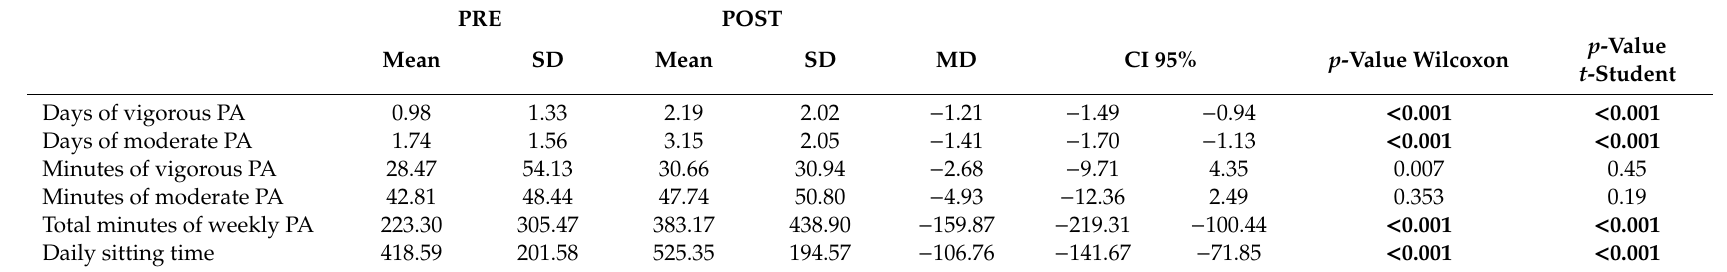
Table 2. International Physical Activity Questionnaire (IPAQ) scores before and during lockdown.